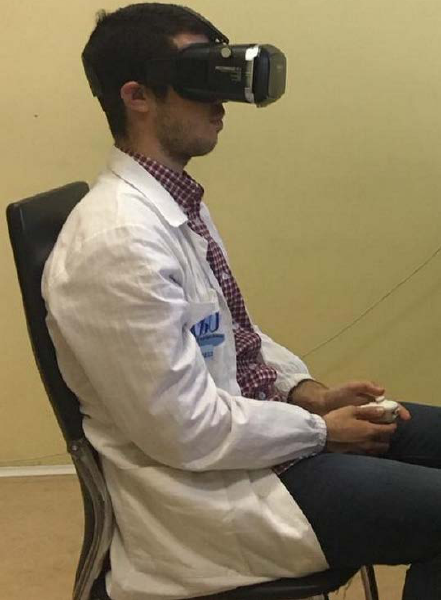
Figure 2. Participant using the mobile device to measure subjective visual vertical (SVV).